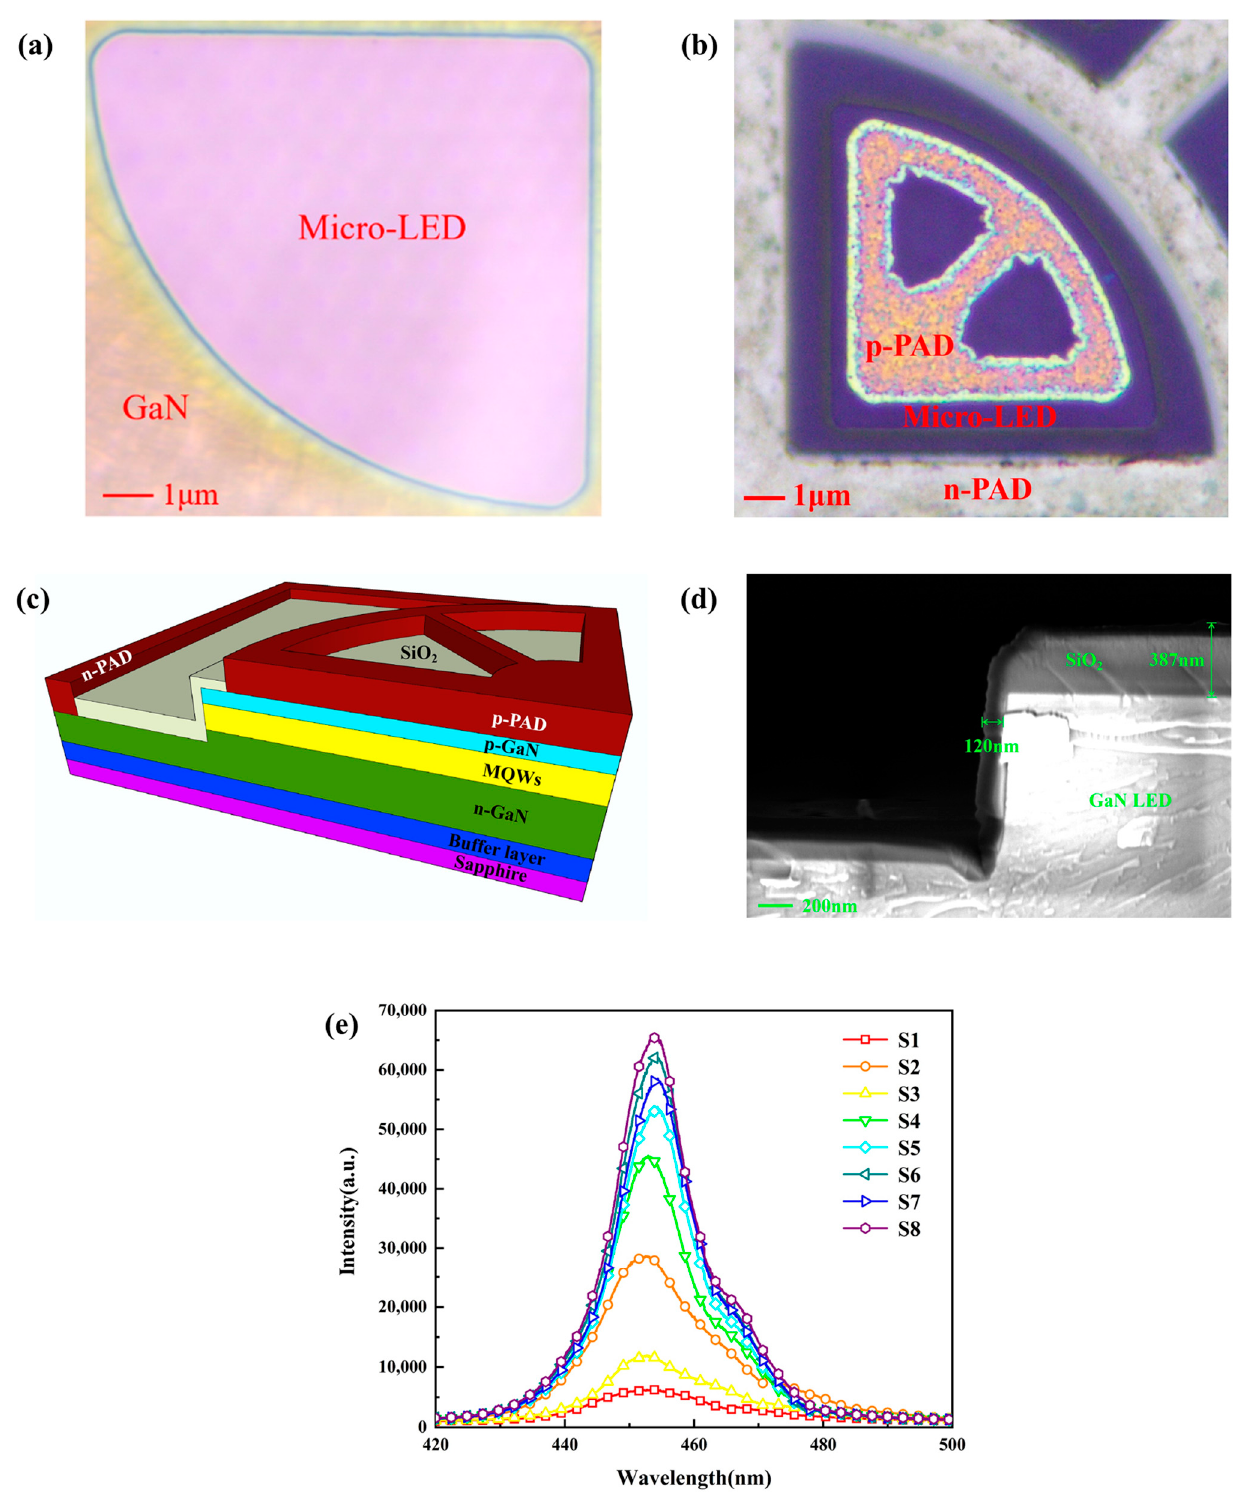
Figure 1. ( a ) Plan view of Micro-LED without electrodes; ( b ) plan view of Micro-LED with electrodes; ( c ) structure diagram; ( d ) SEM image of cross-section; and ( e ) photoluminescence (PL) spectra of 10 µ m-radius Micro-LEDs from S1 to S8.